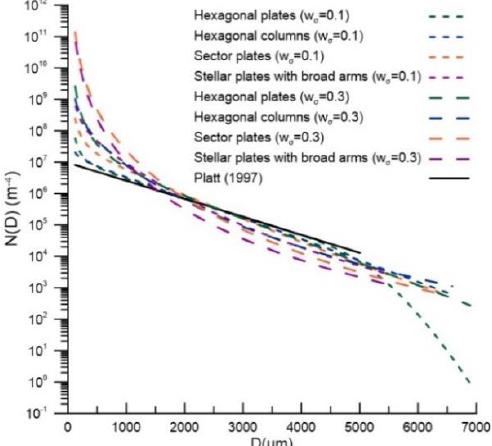
Figure 4. ( a ) Exponential distribution used in this study. ( b ) The Doppler spectral density calculated from the exponential distribution without turbulence (the solid line) and at different turbulence intensities (the dashed line). Radar sensitivity at 5 km of M3 are marked by a solid black line.